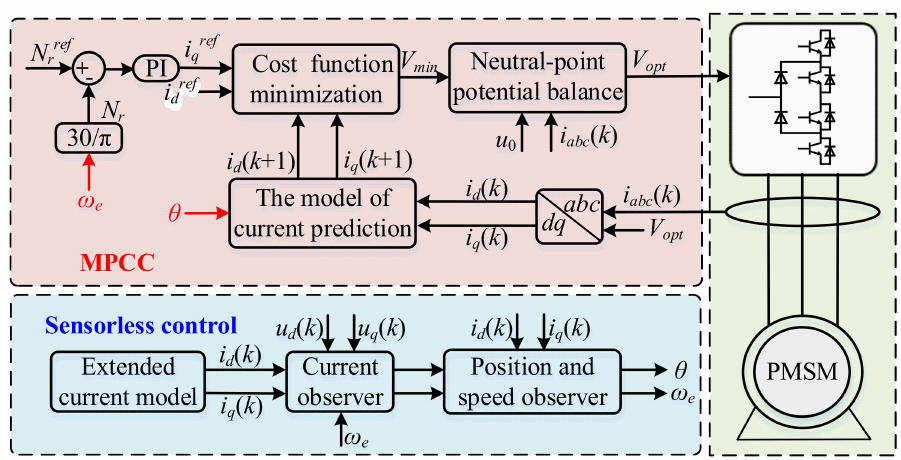
Figure 3. A diagram of the proposed sensorless control